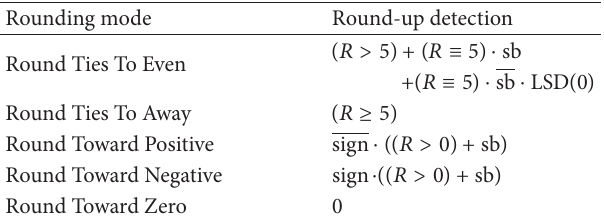
Table 3: Round-up detection. Rounding